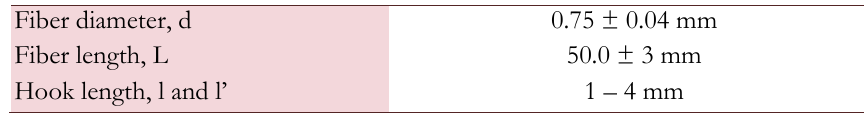
Table 1: Parameters of hooked steel fiber used in experiments.